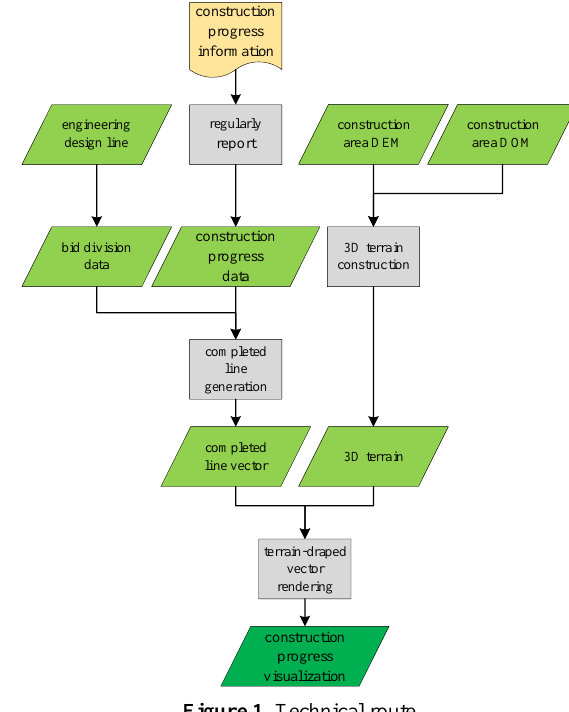
Figure 1 . Technical route